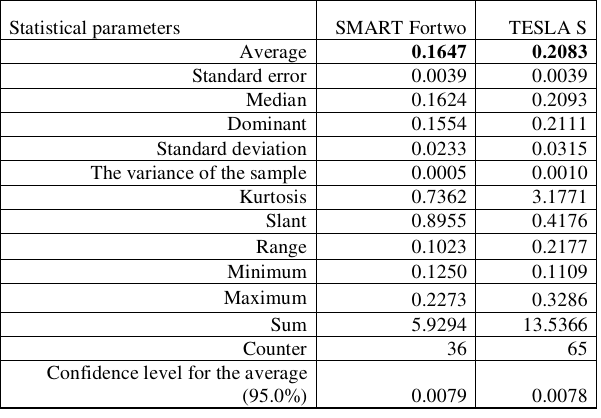
Table 4 Intensity of cumulative energy consumption statistical parameters for analyzed cars types Statistical